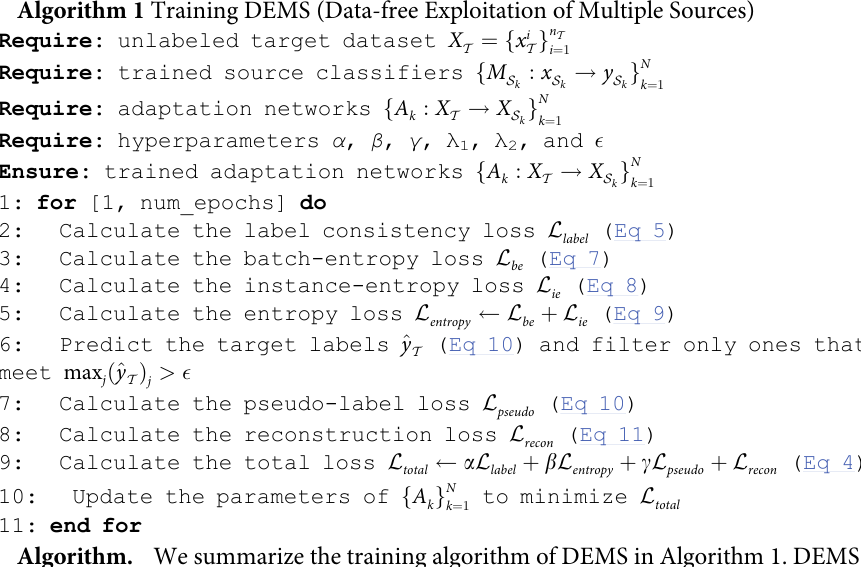
Algorithm 1 Training DEMS (Data-free Exploitation of Multiple Sources)